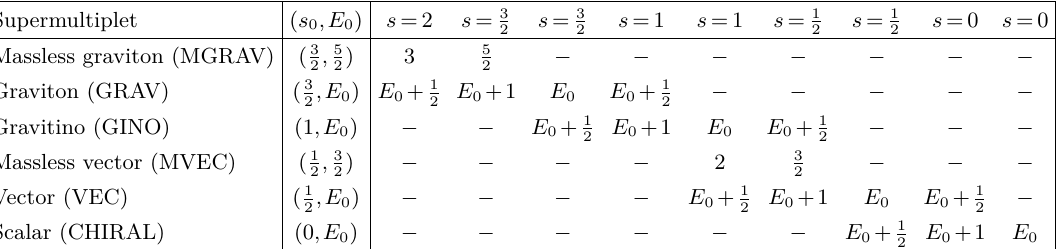
Table 1 . OSp (4 | 1) supermultiplets that appear in the N = 1 KK spectra. For each type of supermultiplet, the spin and energy ( s 0 , E 0 ) of the superconformal primary is given, and the energies of the constituent states, all of them with spins between 0 and 2, are